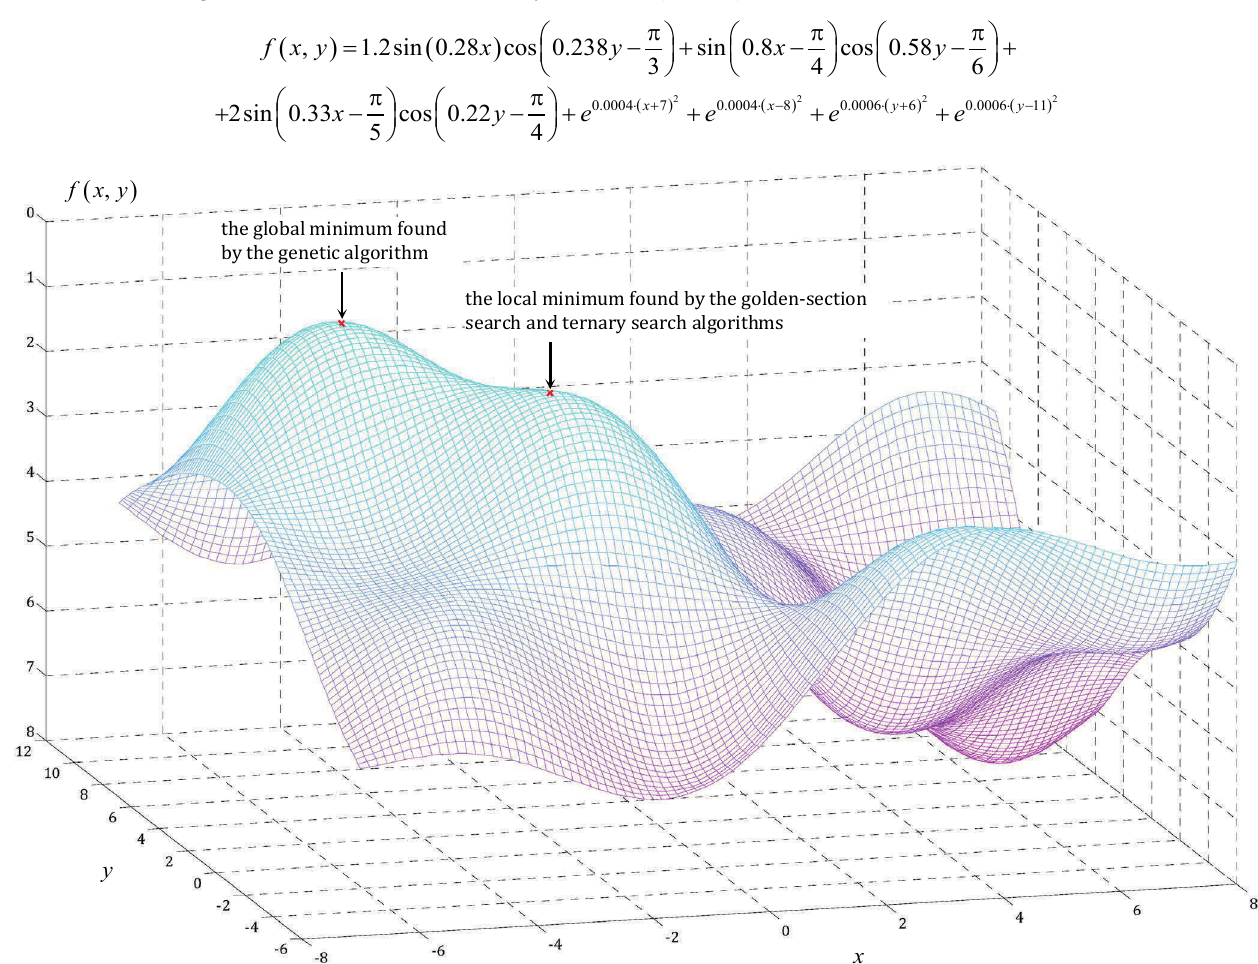
Fig. 1. An example of when both the golden-section search and ternary search find a local minimum and omit the global minimum, whereas the global minimum is found by the genetic algorithm (the surface value axis is shown in reverse direction for easier observation of minima). defined on